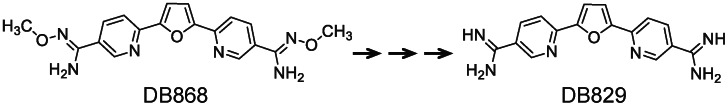
Structures of the prodrug (DB868) and active compound (DB829).